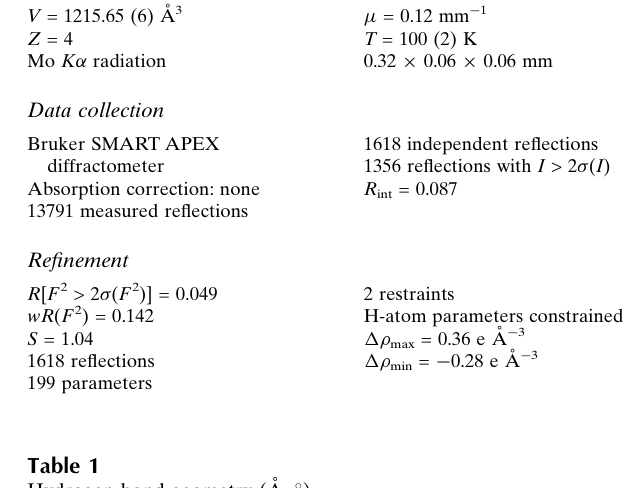
Hydrogen-bond geometry (A˚ , (cid:4)